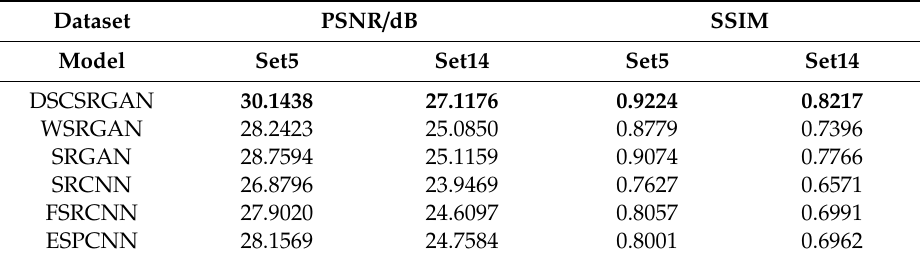
Table 2. Comparison of the quantitative evaluation results of six methods with the Set5 and Set14 datasets.